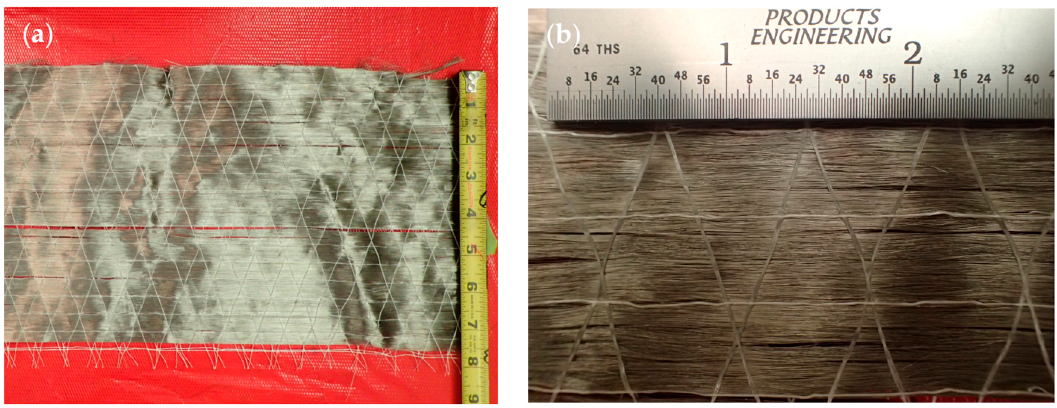
Figure 2. ( a ) Steel reinforcement fibers on the roll; and ( b ) Close up of weave of steel reinforcement fibers. Table 1. Steel fiber chemical